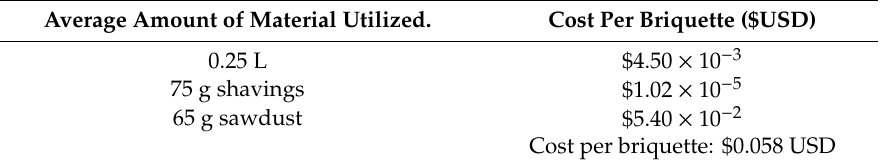
Table 1. Production cost per briquette in dollar ($ USD).